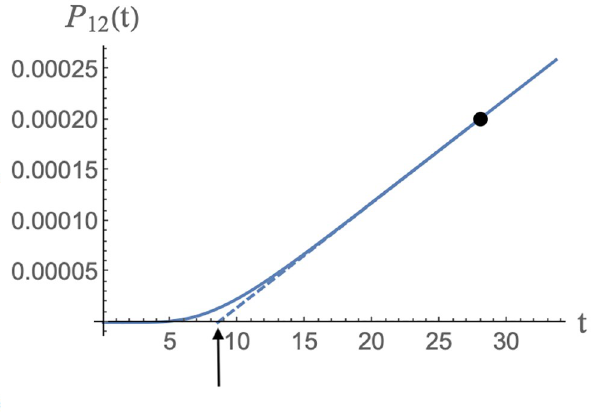
Fig 9. Definition of the delay time as the intersection of the maximum slope tangent to the assembly curve P 12 ( t ) with the time axis, as indicated by the arrow. MLD = 9, N p = 8, � = 0.5, c 0 = 1, D = 0.5 and μ 0 = − 4.